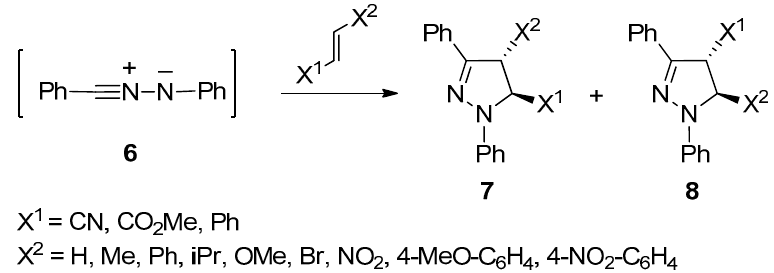
Table 3. Cycloaddition between diphenylnitrilimine 6 and mono- or disubstituted ethenes giving regioisomeric pyrazolines 7 and 8 (RG-III).